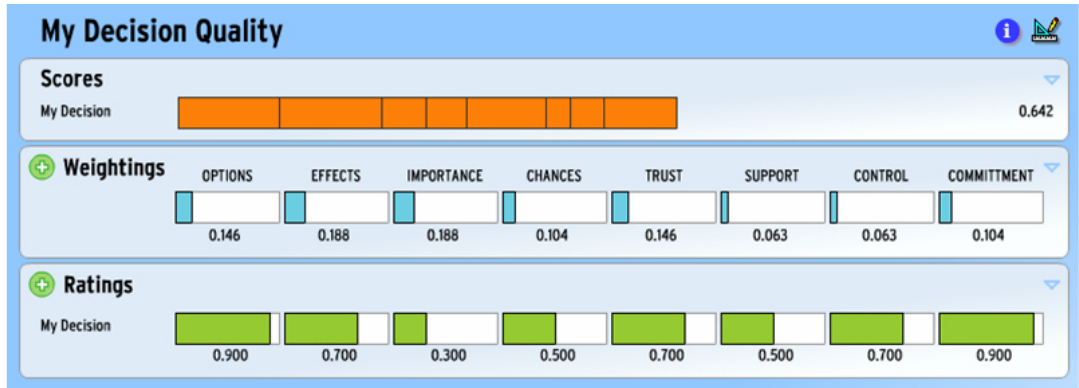
Figure 2. Example of MyDecisionQuality